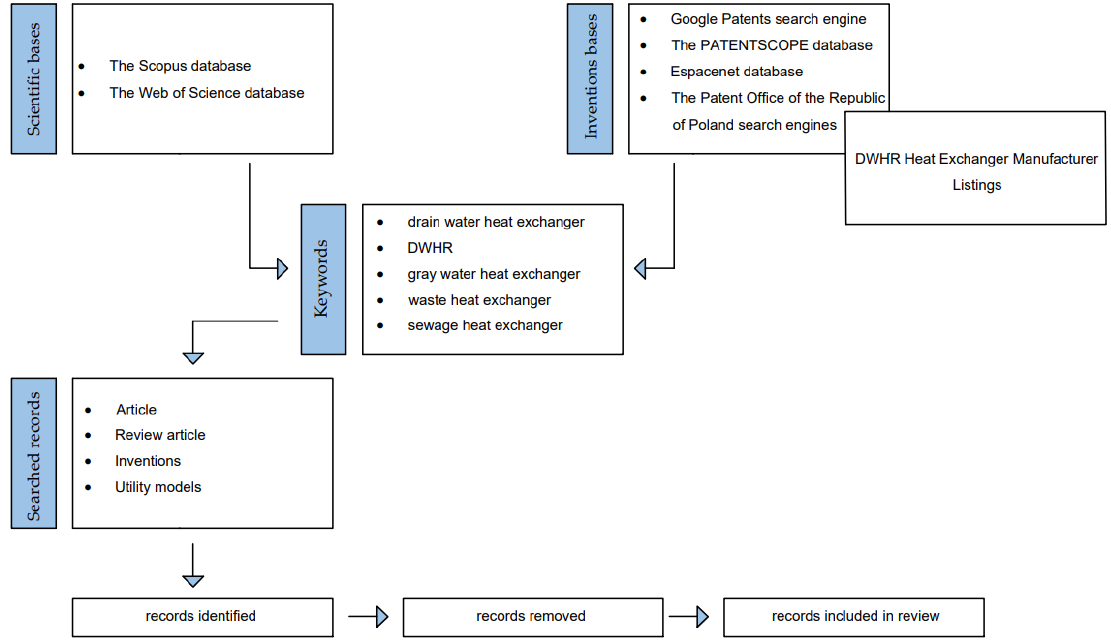
Figure 2. Model reference search.